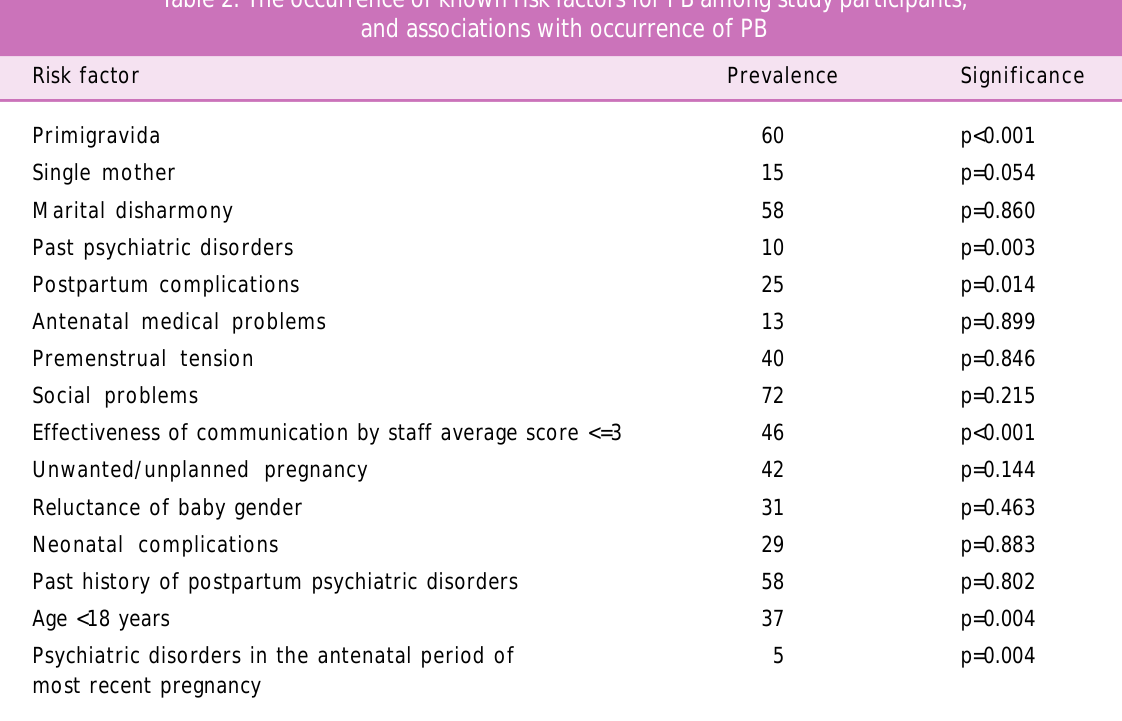
Table 2. The occurrence of known risk factors for PB among study